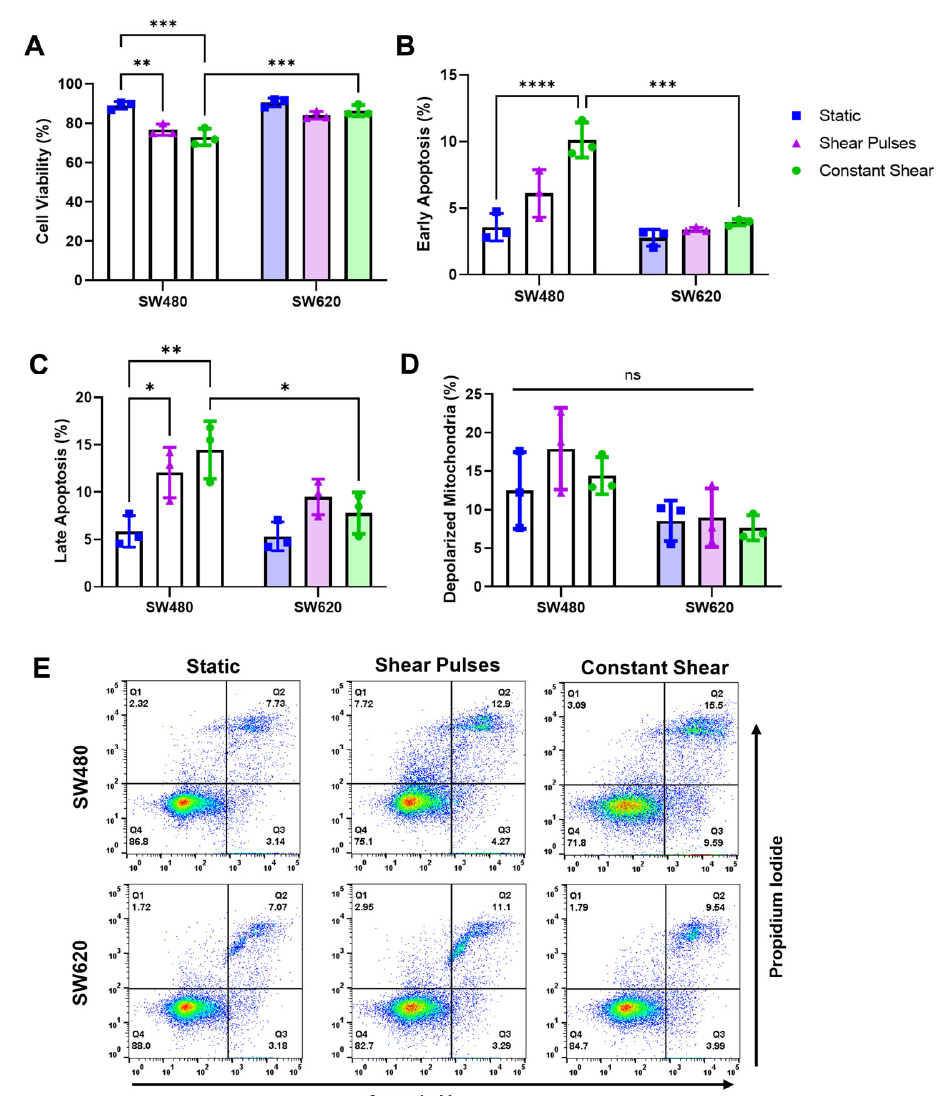
Figure 2. SW480 cells are more sensitive to FSS compared to SW620 cells. ( A – C ) Cell viability and apoptosis measured via Annexin V/PI staining 24 h after FSS treatments. ( D ) Percentage of cells with depolarized mitochondria measured via a JC-1 assay after FSS. N = 3, ns = not significant, * p < 0.05, ** p < 0.01, *** p < 0.001, **** p < 0.0001. (two-way ANOVA with multiple comparisons). Error bars represent mean ± SD. ( E ) Representative flow cytometry plots showing necrotic cells (Q1), late apoptotic cells (Q2), early apoptotic cells (Q3), and viable cells (Q4).